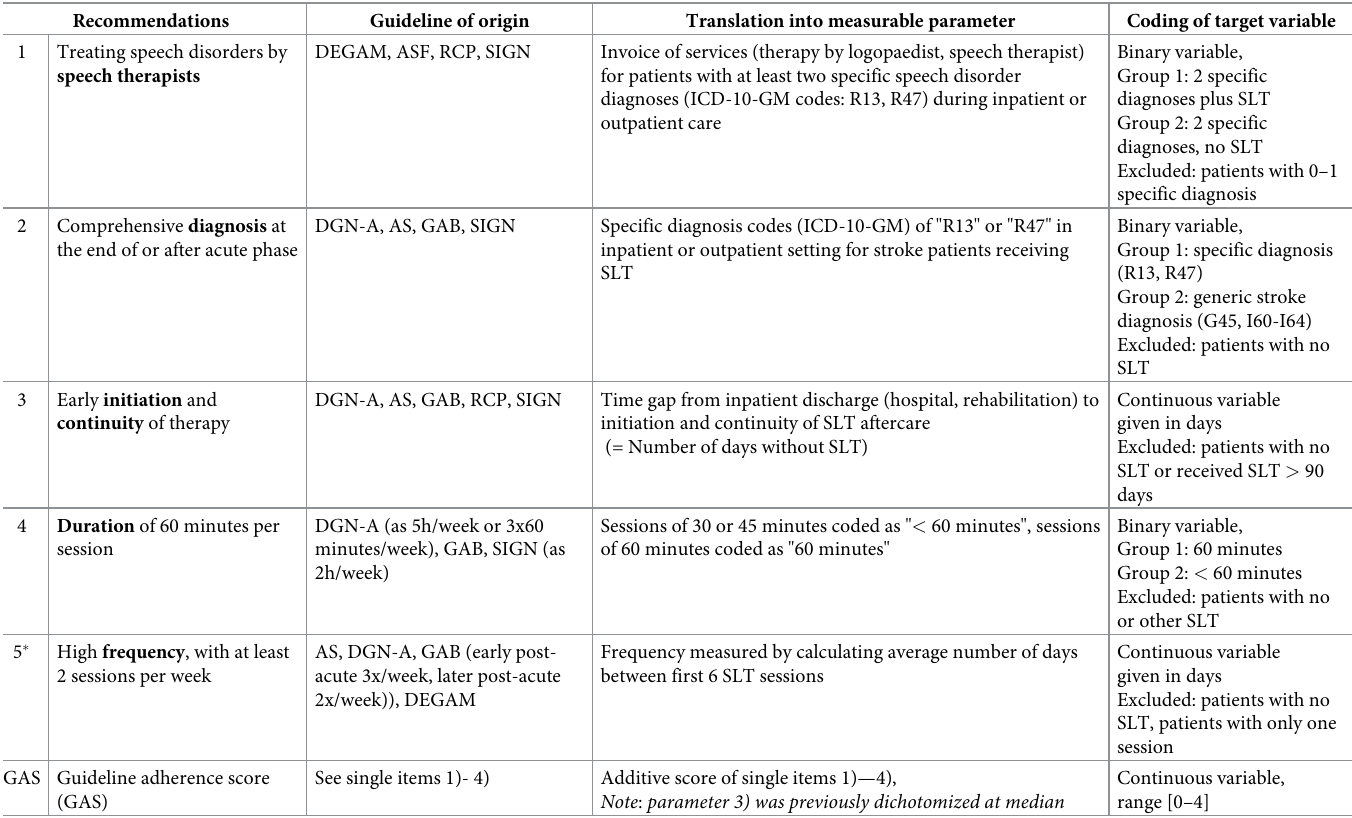
Table 1. Operationalization and origin of test